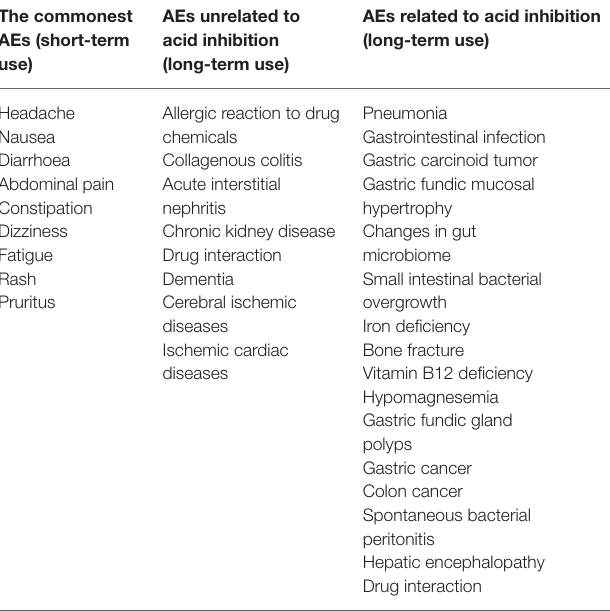
TABLE 2 | Adverse events (AE) reported in patients treated with PPI (21,